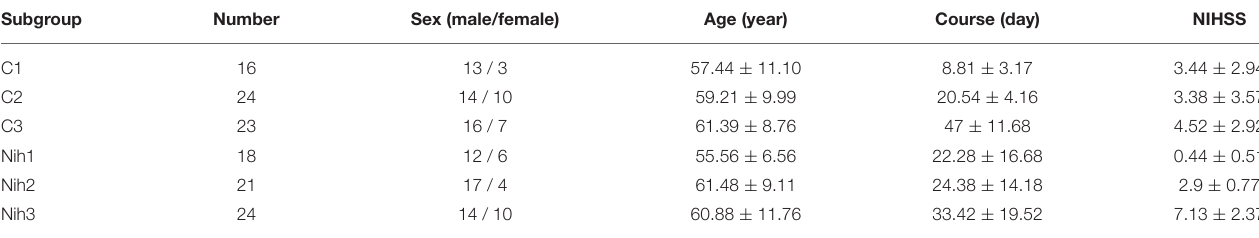
TABLE 3 | Demographic features and clinical data of subgroup patients.